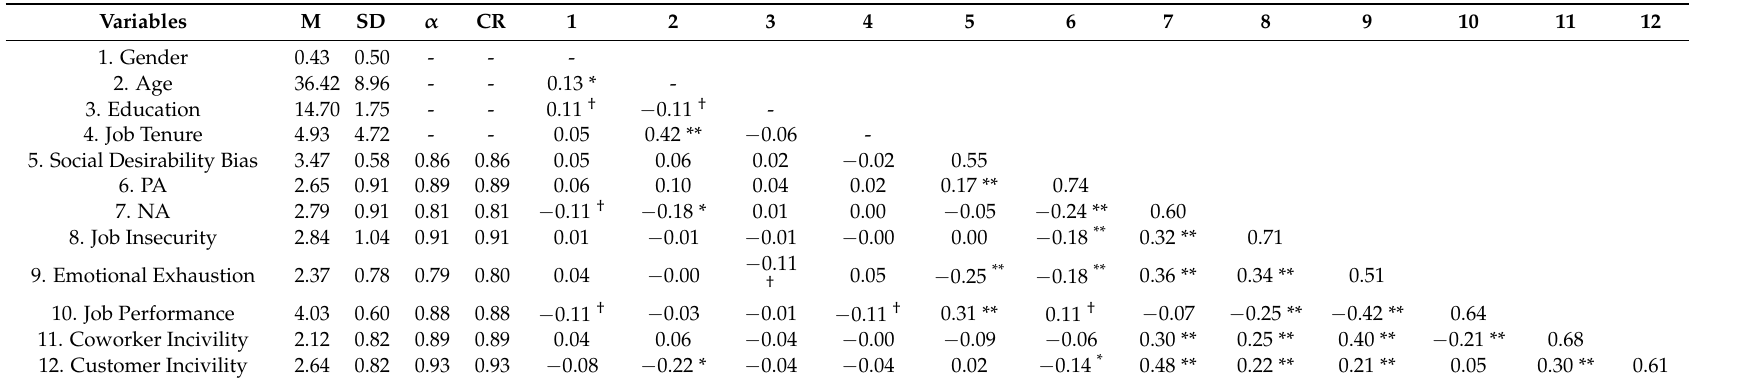
Table 1. Means, standard deviations, and